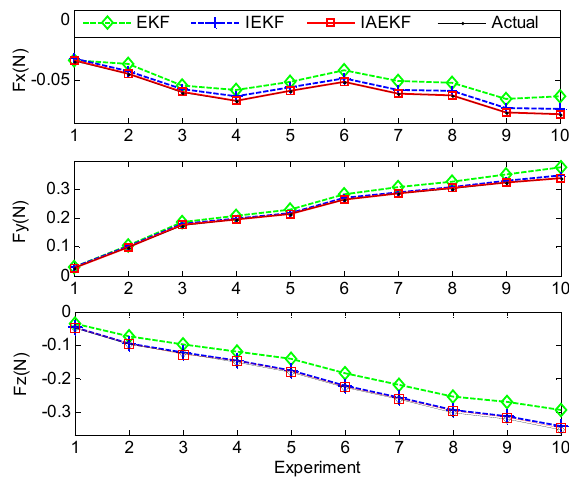
Figure 12. Estimated forces compared with true values for different implemented contact forces in Experiment II with the initial curvature of k 1,0 “ 19.41 m ´ 1 .